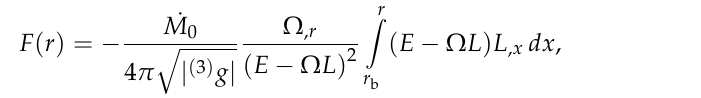
Figure 9. Boundary radii r b / M of SCO regions as functions of Q ( left ) and M ( right ) for several values of M and Q . The corresponding points where curves qualitatively change their behavior by reconnection are ( M , Q ) (cid:39) ( 2.11,1.39 ) and ( M , Q ) (cid:39) ( 1.2,1.67 ) for left and right pictures, respectively and shown by blue